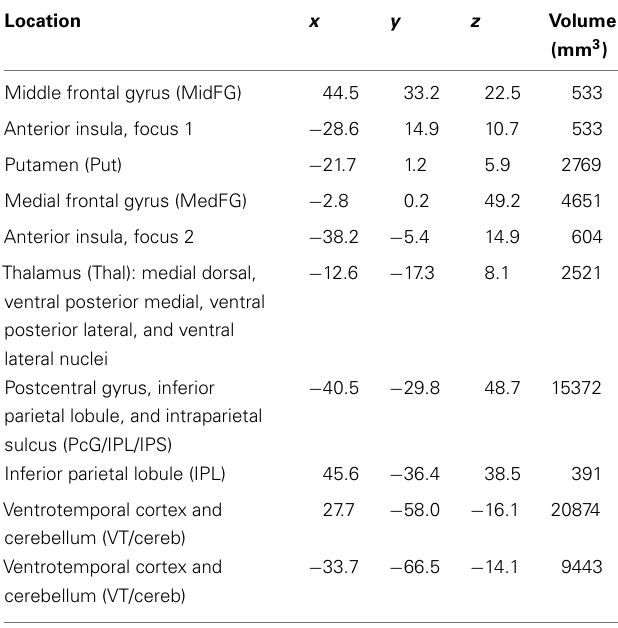
Table 2 | Brain regions active in all